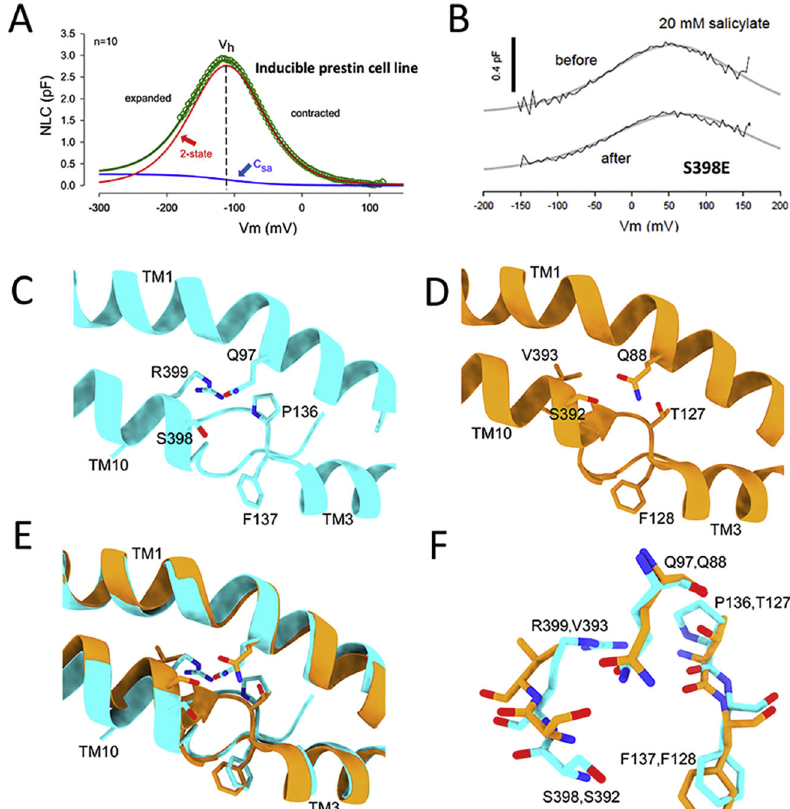
Fig. 3 Nonlinear capacitance represents prestin voltage dependent activity and does not depend on anion binding. A Prestin predominantly resides in the contracted state at 0 mV. Average NLC ( n = 10), 48 h after induction of our inducible prestin HEK stable cell line (#C16). Recordings were done in the presence of 140 mM intracellular Cl. NLC- fi tted (Eq. 1) parameters were Qmax = 0.40; z = 0.70; Vh = − 112 mV; DCsa = 0.26 pF; NLC peaks at V h ; n = 10. B The S398E mutation in prestin preserves NLC after application of 20 mM salicylate. Controls shows full block of NLC. The average unitary gating charge (z) in these mutants (0.69e ± 0.03 SEM, n = 7) was similar to that of CHO cells expressing prestin – YFP (0.73e ± 0.14 SEM, n = 10, P > 0.05). V h was signi fi cantly different, however (96.25 mV± 4.6 WT; + 73.8mV ±6.4, p < 0.05). C Close-up view showing the residues Q97, S398, R399, P136, and F137 in prestin (displayed as sticks, colored by atom type) that correspond to residues found to be important for Cl − binding in Slc26a9 (with prestin in cyan ribbon). The mean z and V h values of fi tted NLC of several mutations of residues that coordinate chloride binding were WT, 0.71e ± 0.03 SEM, − 98.12 mV ± 2.33SEM n = 9; Q97A 0.65 ± 0.04, − 94.1 mV ± 5.29, n = 5; P136T 0.64 ± 0.05 SEM, − 88.15 ± 10.1 SEM, n = 9. The differences were not signi fi cant ( p = 0.54, one-way ANOVA for z; p = 0.605, one-way ANOVA for Vh). D Close-up view of the corresponding region in the Slc26a9 structure (the “ inward-facing ” , open conformation, in orange ribbon). Residues Q88, S392, T127, and F128 (in stick representation) are involved in Cl-coordination in Slc26a9. E The location of the Cl binding site at the interface between TM1, TM3, and TM10 is conserved in prestin and Slc26a9. Overlay of portions of the transmembrane helices 1, 3, and 10, from prestin and Slc26a9, as shown in panels ( C , D ). F Overlay of the Cl-binding sites of prestin and Slc26a9 ( “ inward- facing ” , open conformation). Equivalent residues are shown as pairs. Cyan sticks are prestin residues and orange sticks are Slc26a9 residues. Source data are provided as a Source Data fi